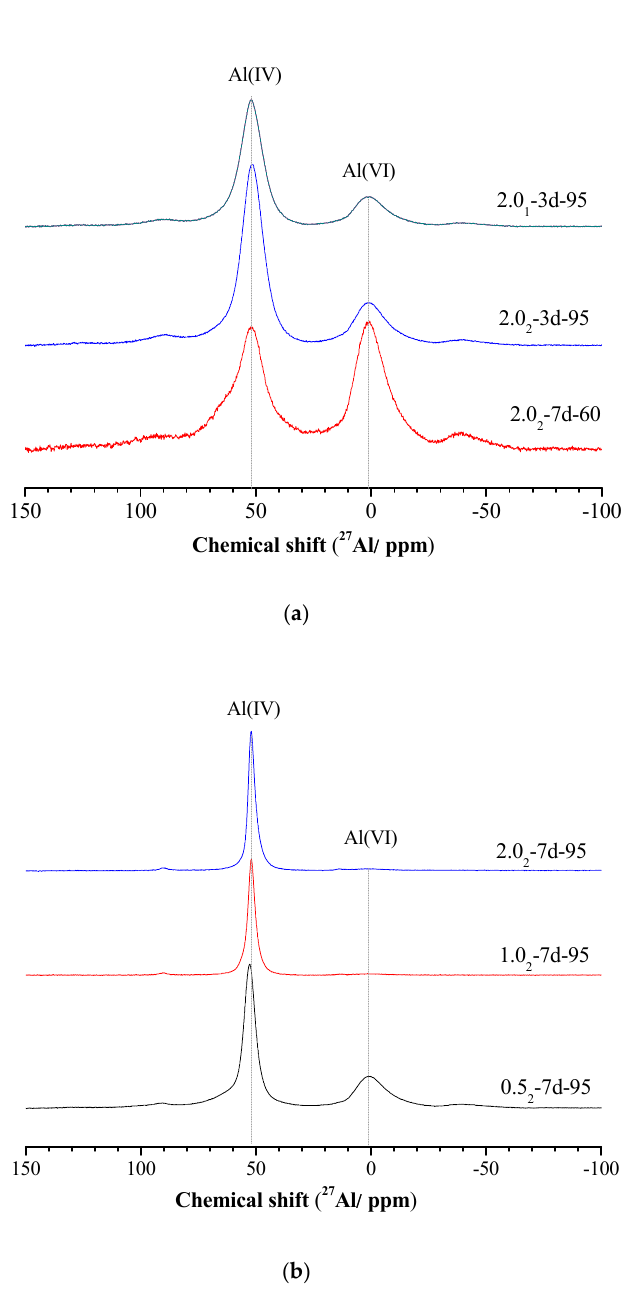
Figure 4. 27 Al MAS-NMR spectra of K-A-S-H samples ( a ) synthesized at different reaction temperatures and SiO 2 /Al 2 O 3 , ( b ) synthesized using different K 2 O/SiO 2 ratios by reaction at 95 °C.